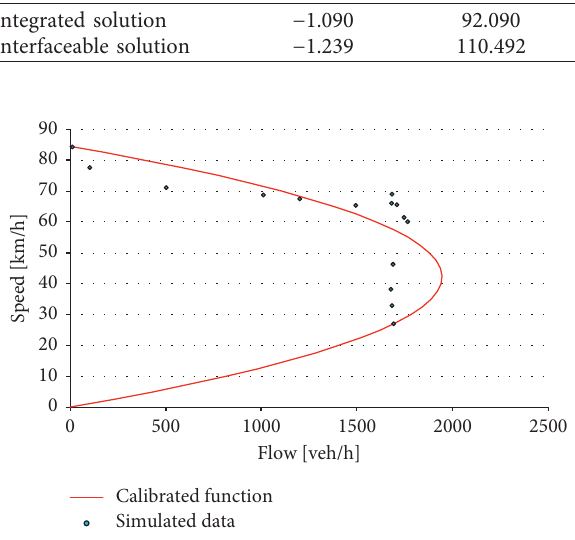
Figure 5: Calibrated function f � f ( v ) in the case of network configuration 1 for the integrated solution.